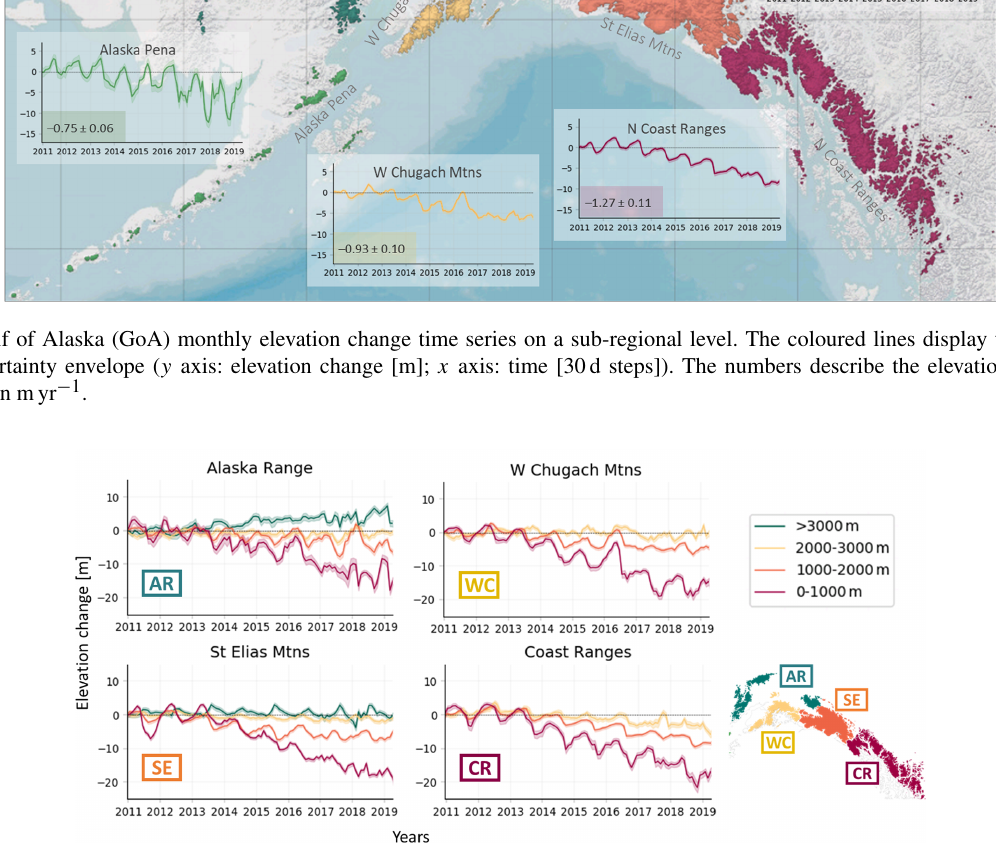
Figure 10. Gulf of Alaska (GoA) monthly surface elevation change time series with uncertainty envelopes at different elevation bands aggregated on the RGI 6.0 second-order regions. The different colours represent the elevation bands ( > 3000, 2000–3000, 1000–2000, 0–